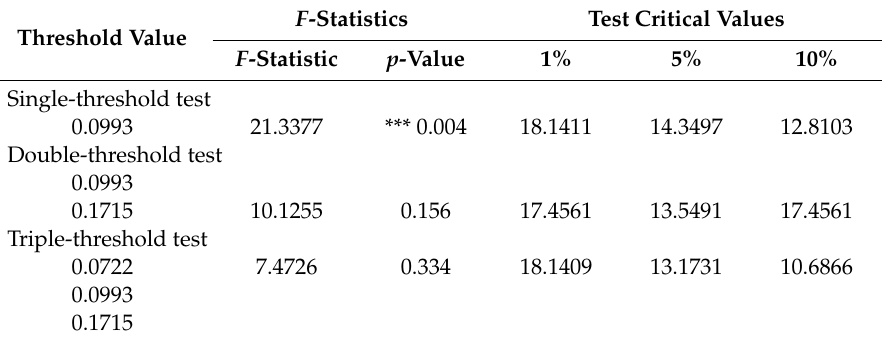
Table 3. Test results of threshold e ff ect of cash holding ratio on firm’s